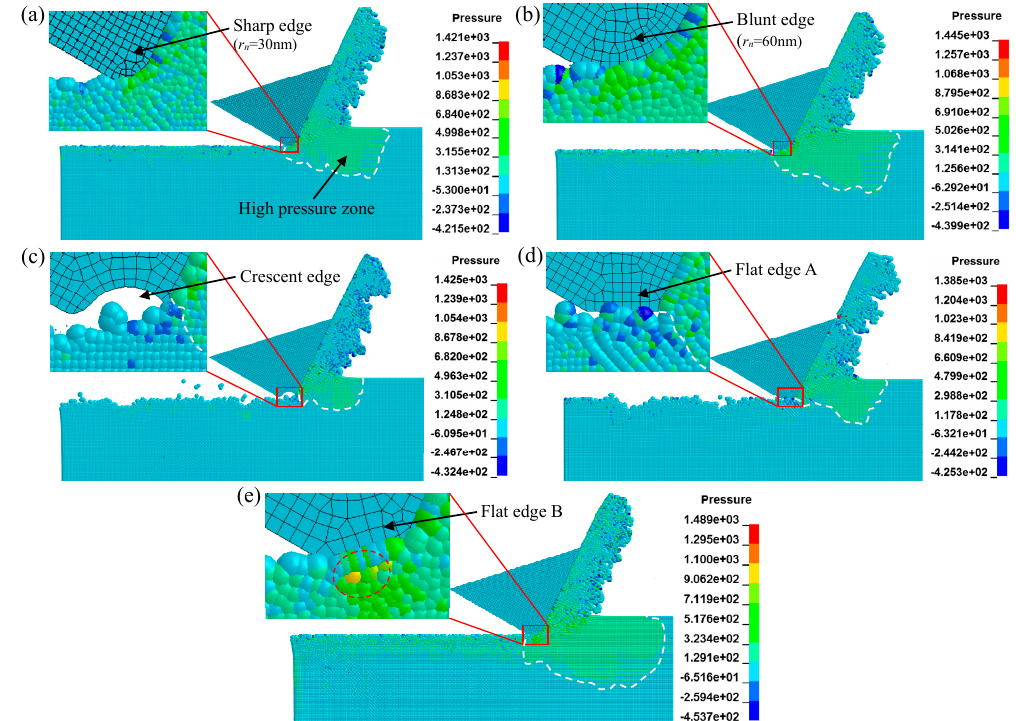
Figure 8. Hydrostatic pressure distribution in the cutting simulations of different types of cutting edge: ( a ) sharp edge with r n = 30 nm, i.e., the normal group simulation; ( b ) blunt edge with r n = 60 nm; ( c ) crescent edge; ( d ) flat edge A; and ( e ) flat edge B.